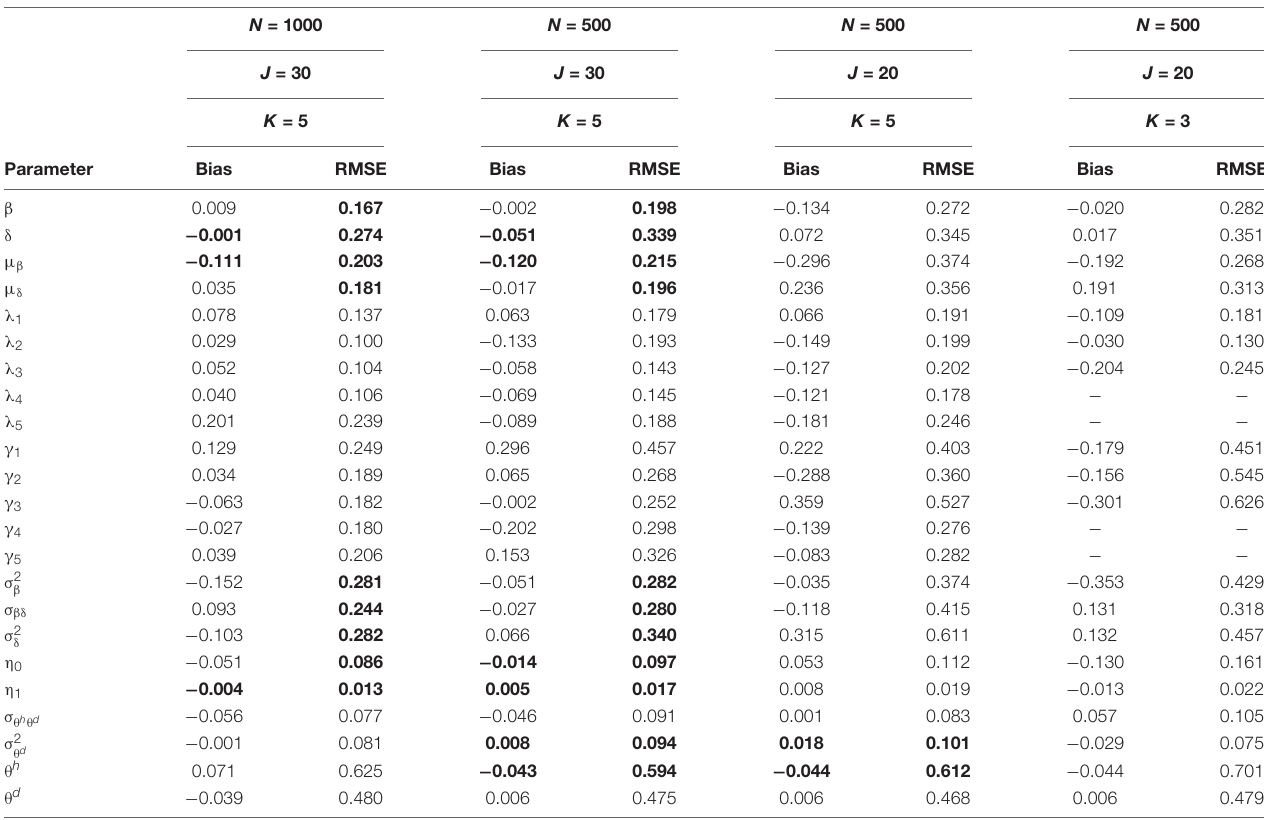
TABLE 1 | Bias and RMSE of the parameter estimates in simulation studies I and